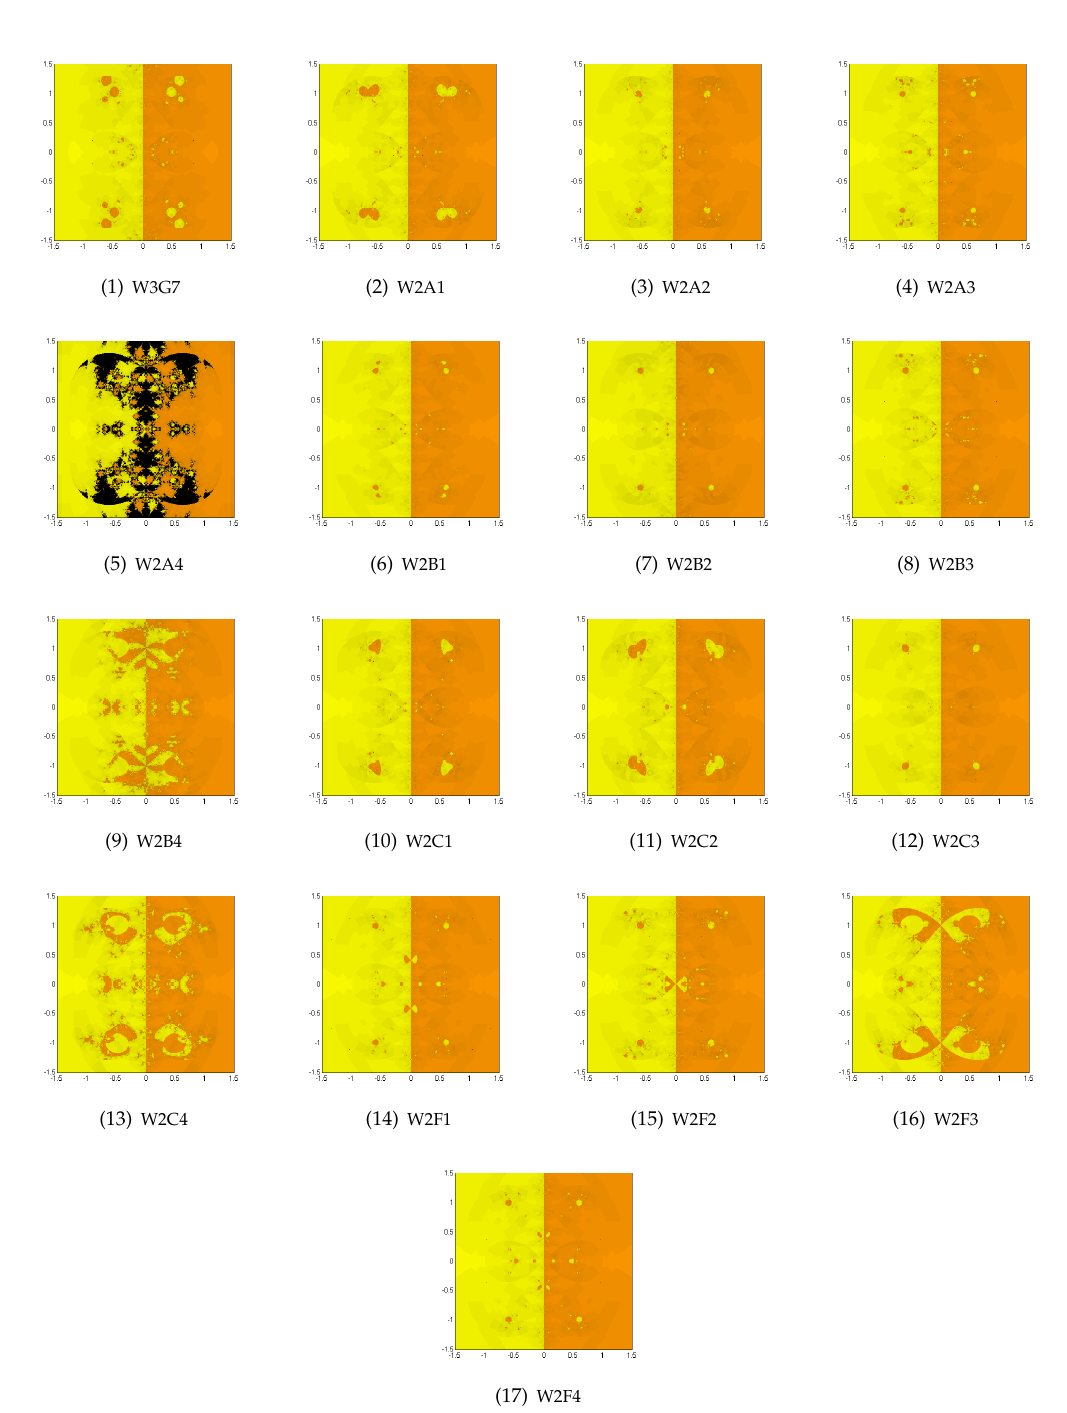
Figure 1. The top row for W3G7 ( left ), W2A1 ( center left ), W2A2 ( center right ) and W2A3 ( right ). The second row for W2A4 ( left ), W2B1 ( center left ), W2B2 ( center right ) and W2B3 ( right ). The third row for W2B4 ( left ), W2C1 ( center left ), W2C2 ( center right ) and W2C3 ( right ). The third row for W2C4 ( left ), W2F1 ( center left ), W2F2 ( center right ), and W2F3 ( right ). The bottom row for W2F4 ( center ), for the roots of the polynomial equation ( z 2 − 1 ) 2